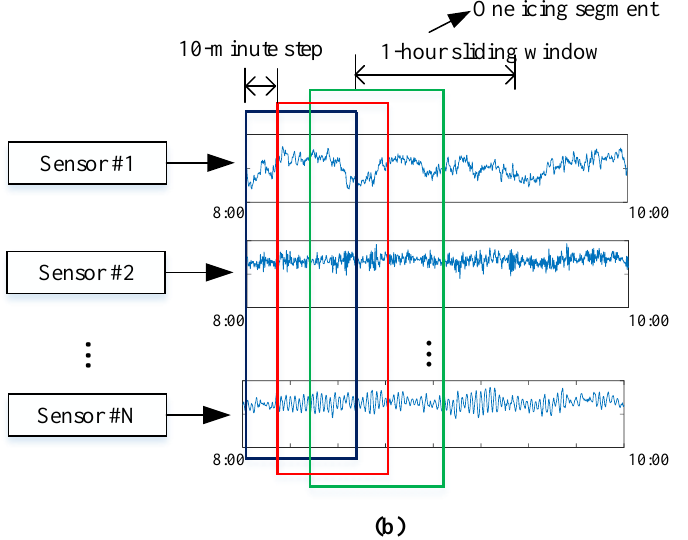
Figure 7. An illustration diagram of data sample generation procedure for ( a ) normal samples and